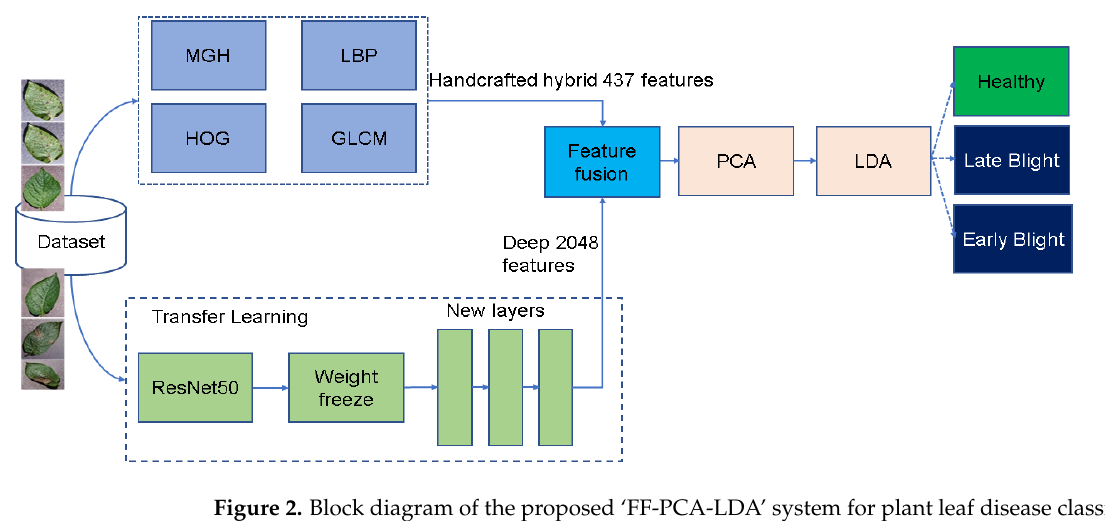
Figure 2. Block diagram of the proposed ‘FF-PCA-LDA’ system for plant leaf disease